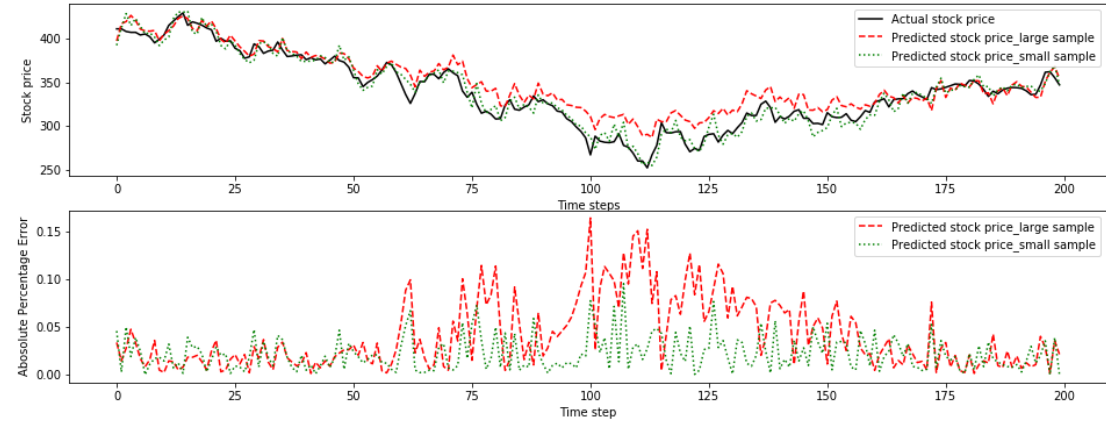
Figure 5. Performance of Tencent by EMD + ANN over different sample sizes.